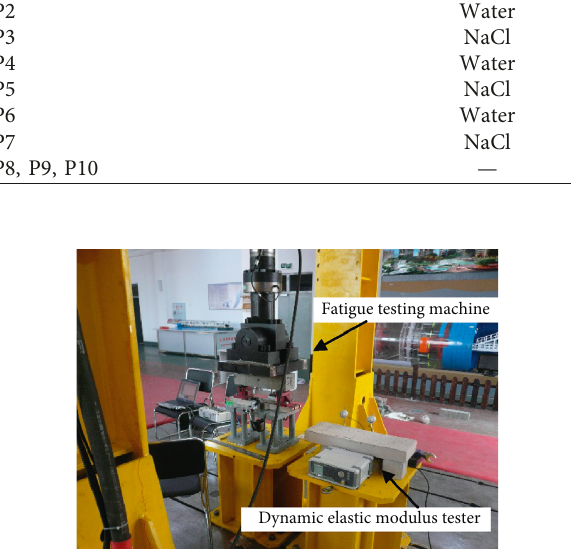
Figure 2: Fatigue testing machine.